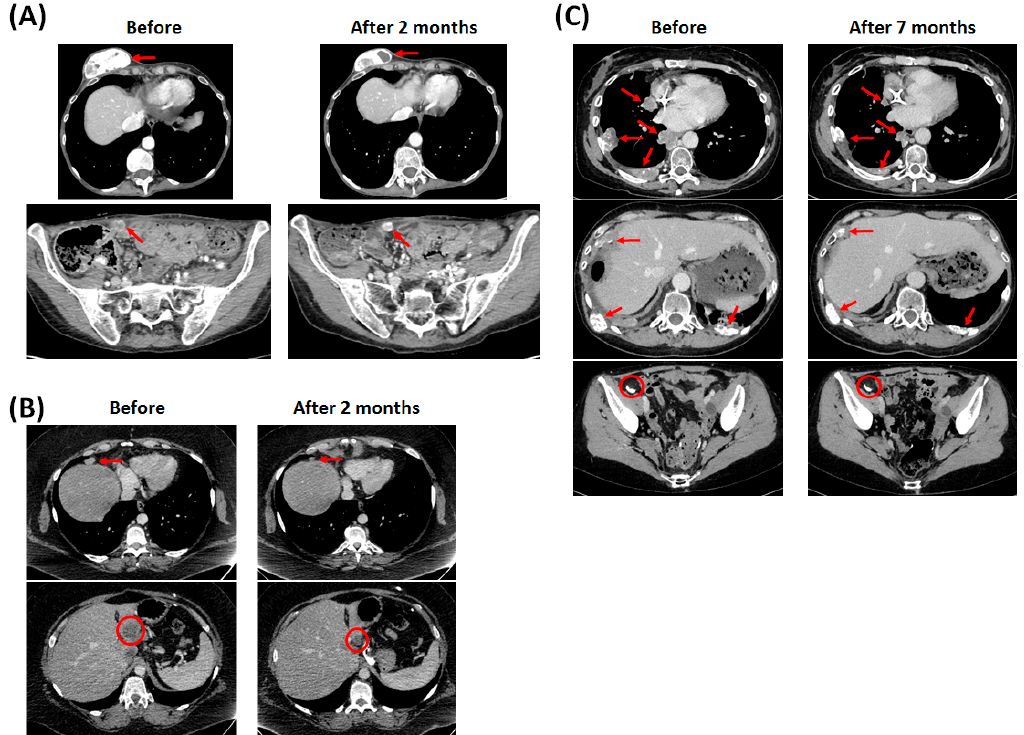
Figure 1. Computed tomography imaging results before and during the treatment of the anti-EGFR antibody and MEK inhibitor combination from patient of case n°1 ( A ), case n°2 ( B ) and case n°3 ( C